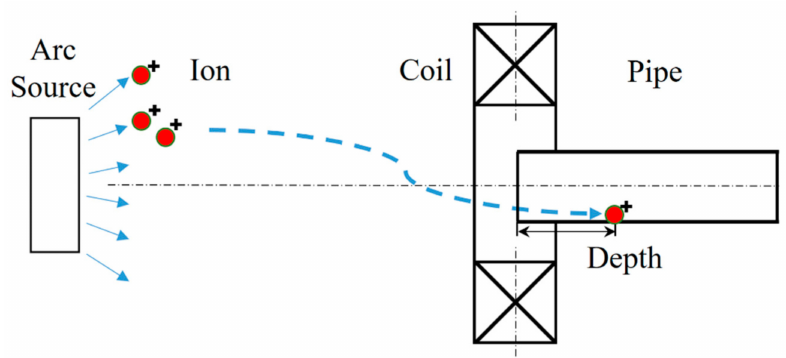
Figure 1. Schematic diagram of the vacuum arc deposition for the inner surface of a